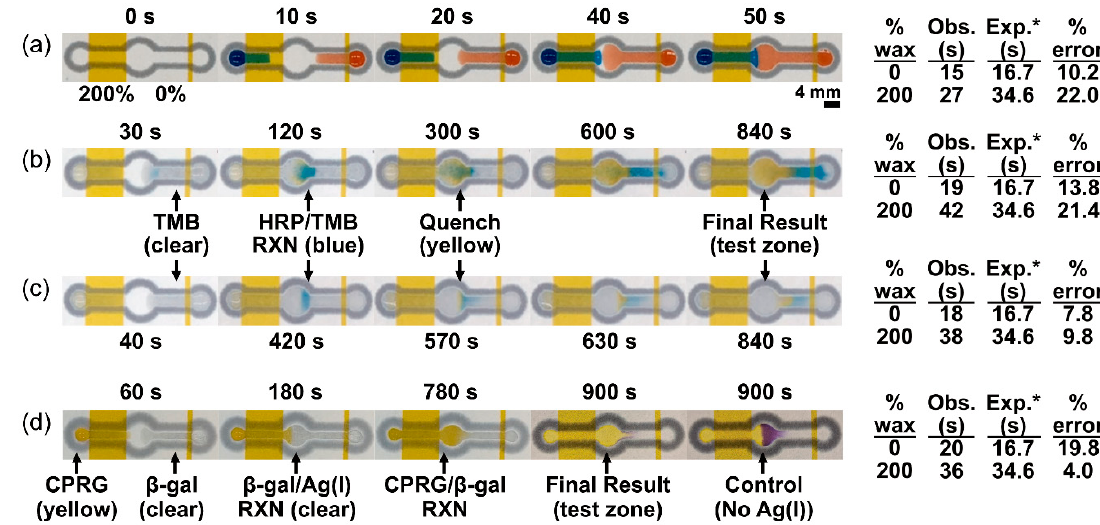
Figure 3. Automated multi-step enzymatic assays via wax-printed fluidic time delays. ( a ) Time-lapse images of sequential dye delivery in a microPAD with 2 channels (7.5 mm × 4 mm) (left channel = 200% wax, right channel = 0% wax). Red dye (right) enters test zone first (15 s), followed by the blue dye (left) (27 s). ( b ) Time-lapse images of an automated HRP assay (1.25 µ L of 146 U/mL HRP deposited in test zone), followed by an H 2 SO 4 quench. The HRP/TMB reaction first produces a blue color, and the acid quench produces a yellow color. ( c ) Time lapse images of an automated HRP assay with a lower amount of HRP deposited (1.25 µ L of 14.6 U/mL HRP). This reaction produced a reduced color intensity as compared to the higher HRP concentration. ( d ) Time-lapse images of an automated enzyme inhibition assay for Ag(I) ion [23]. β -galactosidase was added to the right channel (0% wax), CPRG (colorimetric substrate for β -gal) was placed in the left channel (200% wax), and 1 ppm Ag(I) ion was deposited in the center test zone. β -gal inhibition by the Ag(I) ion indicates successful automation of the assay. Lighter yellow color in the 900 s images as compared to the 780 s image is due to the drying of the CPRG solution. Abbreviations: HRP refers to horseradish peroxidase, TMB refers to the colorimetric substrate for HRP, RXN means reaction, β -gal = β -galactosidase, CPRG refers to the colorimetric substrate for β -gal, Ag(I) =is silver (I) ion (heavy metal), Obs. means observed, Exp. means expected, * means expected calculated based on the results from Figure 1c & Table A1. The dimensions of the channels and volumes of fluids used in the two experiments were different, however, these values allow for an approximate prediction of wicking time given the channel length and % wax